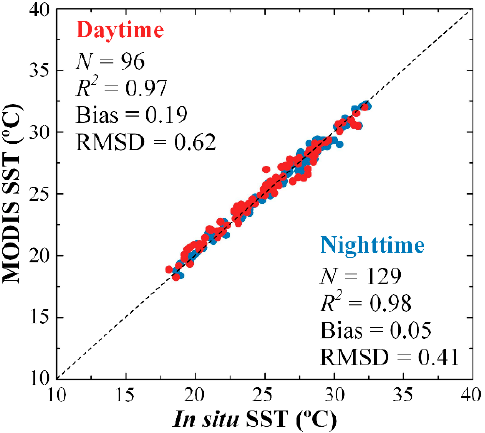
Figure 5. Comparison between in situ SST and MODIS SST in FB from August 2018 to August 2020. The dotted line is the 1:1 line. Data are color-coded for daytime (red) and nighttime (blue). From 33 ECOSTRESS and MODIS image pairs between August 2018 and August 2020, mean bias and RMSD were calculated for ECOSTRESS SST. For daytime and nighttime data combined, mean bias and RMSD in ECOSTRESS SST are − 0.92 and 1.24 °C, respectively. For daytime data, they are − 0.76 and 1.24 °C, respectively. For nighttime data, they are − 1.05 and 1.24 °C, respectively. ECOSTRESS SST is lower than MODIS SST